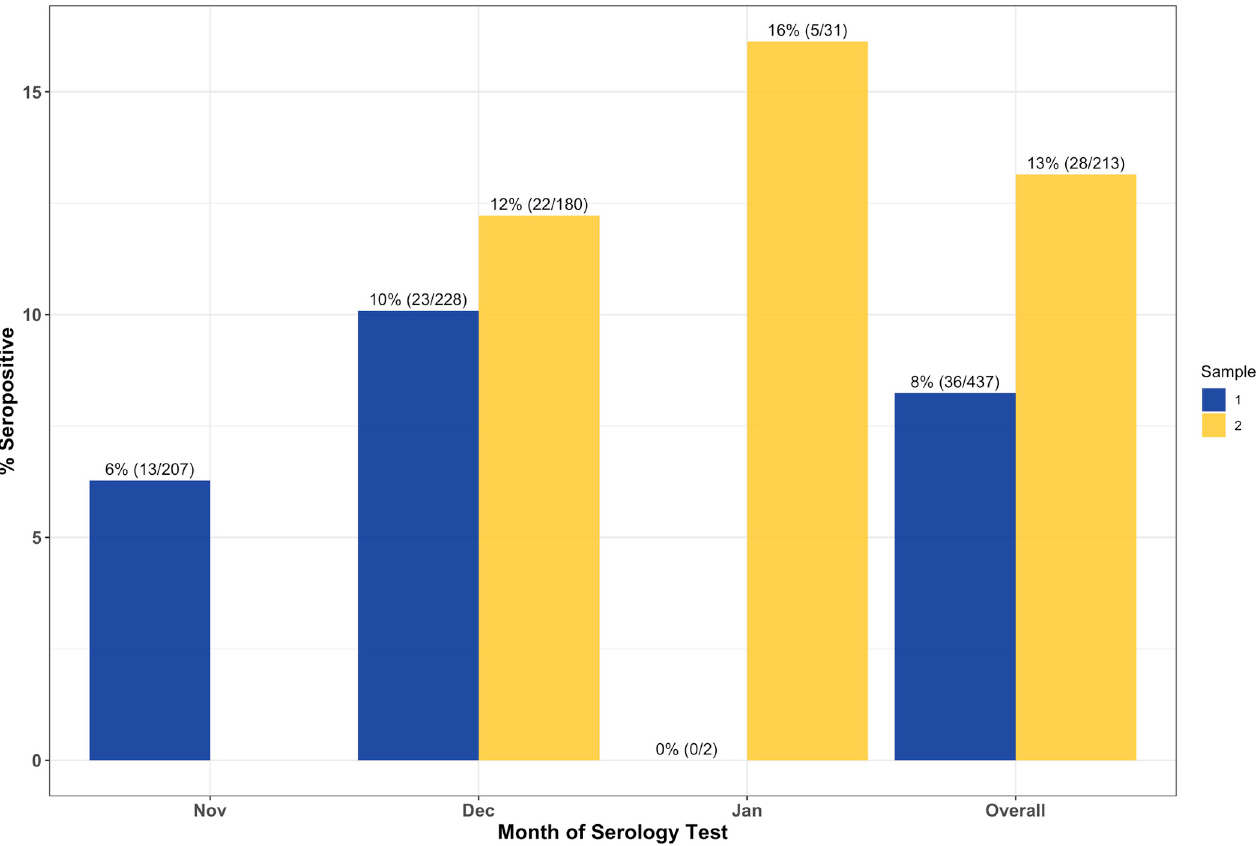
Fig 4. SARS-CoV-2 seroprevalence by month for sample 1 and sample 2 serology testing among only those who were not vaccinated for COVID-19 prior to the day of serology testing. There are 2 samples from February or without a date of collection included in the overall results. %(N/total) presented above each